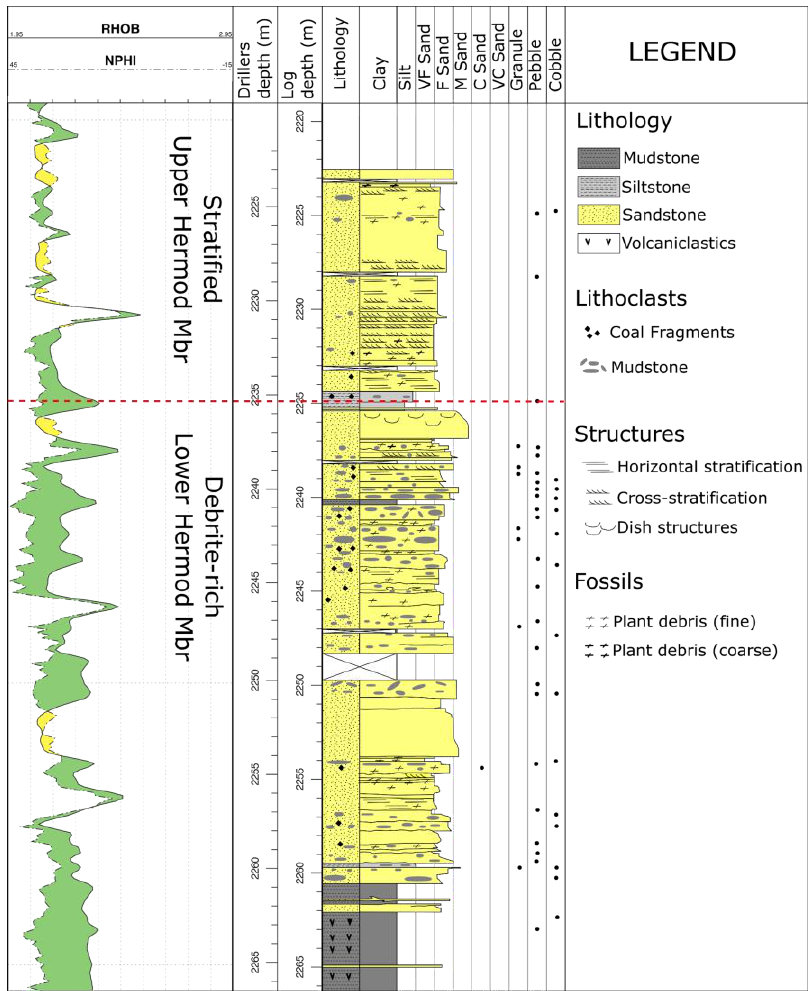
Figure 12. Overview log of the cored Hermod S2 Mbr, Caterpillar discovery, well 24/9-10S. The left-hand column shows a standard density-neutron geophysical log (RHOB—corrected bulk density, g/cm 3 ; NPHI—Neutron Pulsa Hydrogen index, also known as compensated neutron porosity, v / v ). Intervals with shale log response are coloured in green whereas those with sand log response are coloured in yellow. The boundary between the stratified Upper Hermod S2 Mbr and the debrite- rich lower Hermod S2 Mbr is marked by a red dashed line. Note a greater sand response in the upper part and the lower unit having more shale characteristics, most likely due to a very high proportion of shale debris.